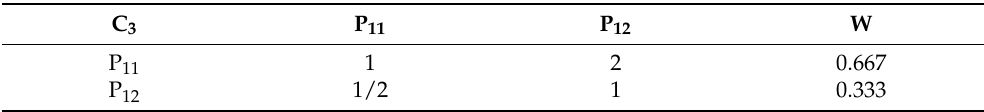
Table 9. The results of matrix and its consistency test between Constraint layer (C 3 ). and Standard layer (P 11 –P 12 ).